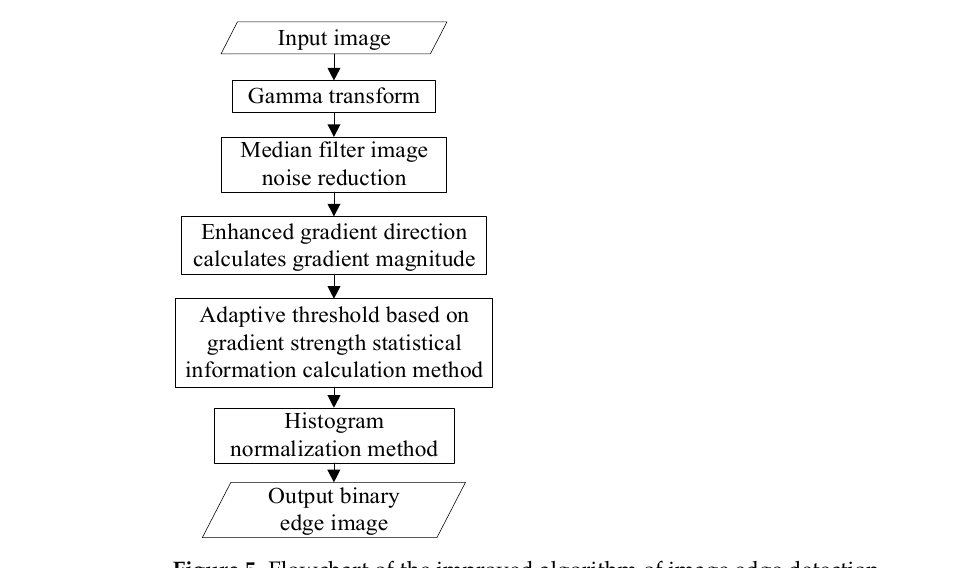
Figure 5. Flowchart of the improved algorithm of image edge detection.